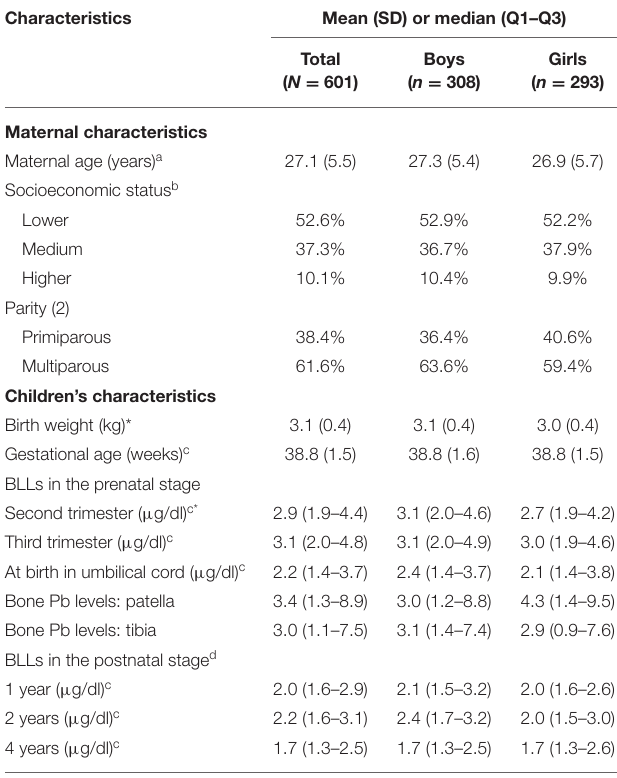
TABLE 1 | Basal characteristics in mother–child dyads from the PROGRESS cohort.